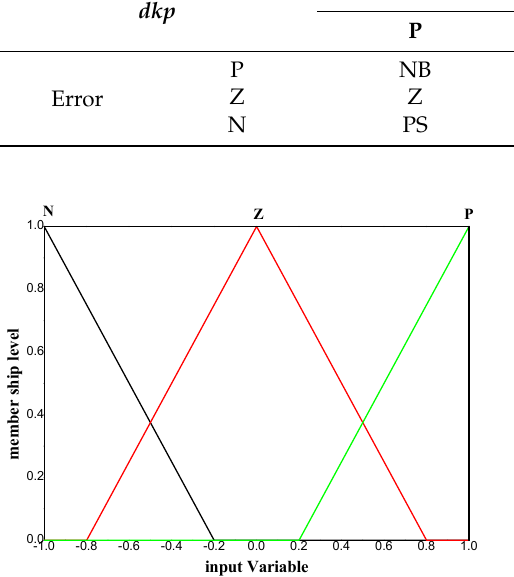
Figure 6. Fuzzy sets of the inputs.